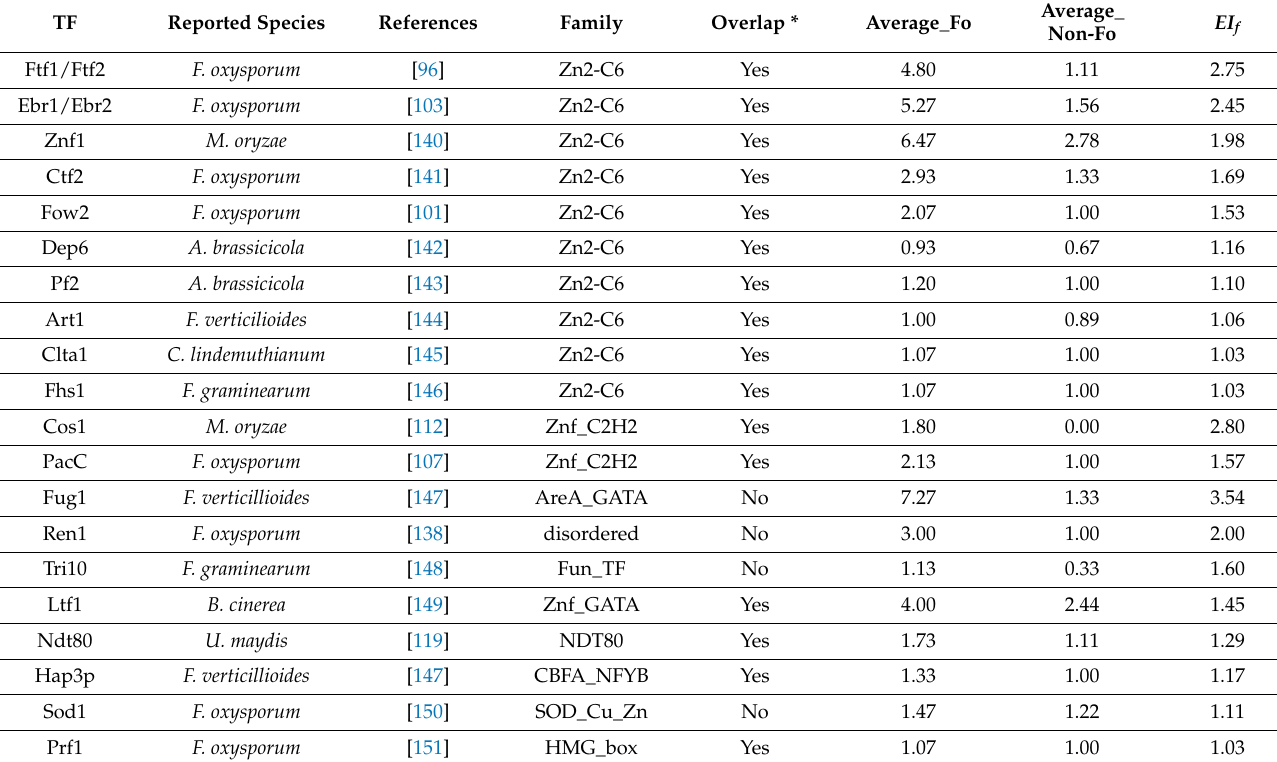
Table 3. Ortholog copy number and expansion index ( EI f ) of the characterized and expanded TFs in F. oxysporum